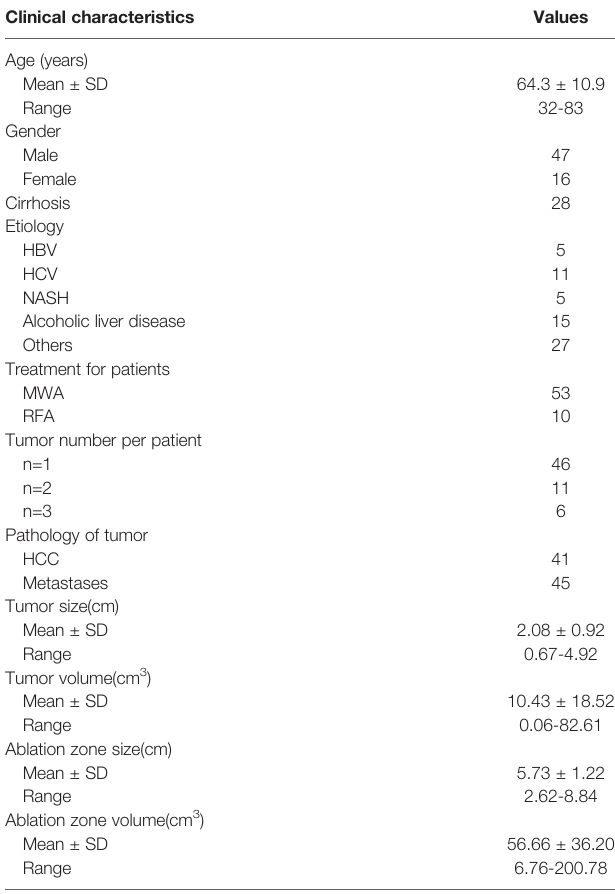
TABLE 1 | Characteristics of 63 patients in local clinical